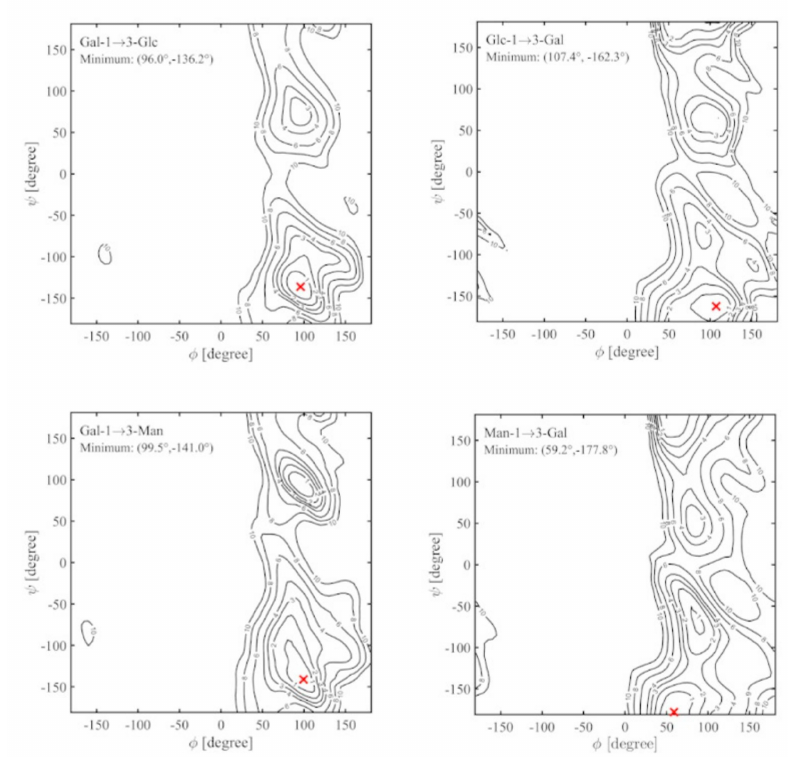
Figure 5. Fully relaxed conformational energy maps for each of the four linkages in the Epol H111-INS polysaccharide. The global minimum is shown with a red “x”. Contour levels are indicated in kcal / mol above the global minima at levels 1, 2, 3, 4, 6, 8, and 10.